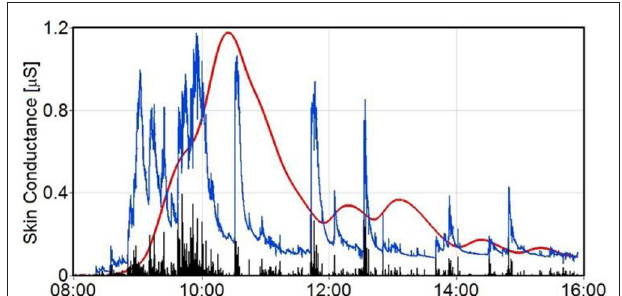
FIGURE 4 | Raw skin conductance trace (blue) with calculated cumulative cortisol estimates (red trace) caused by the psychological stressors. Peak heights are shown as black spikes.